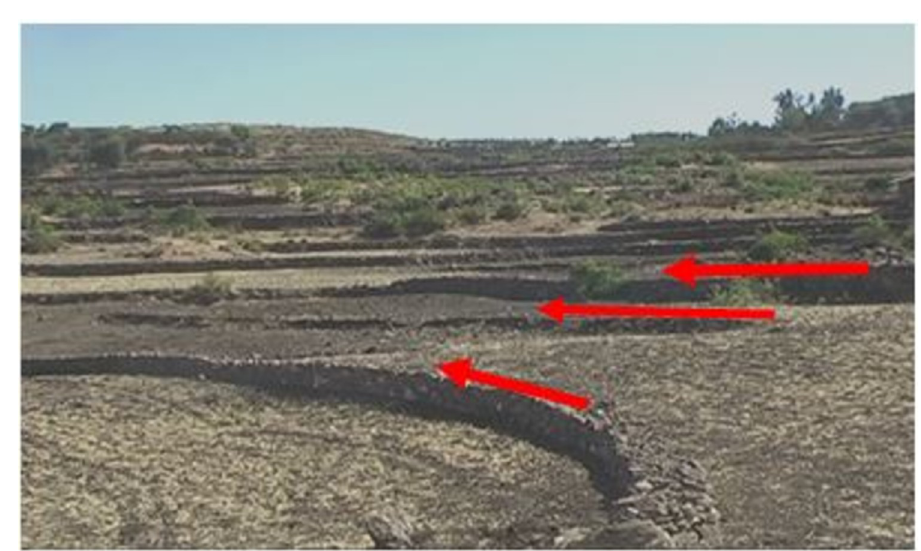
Fig 3. Stone bund in the study area.